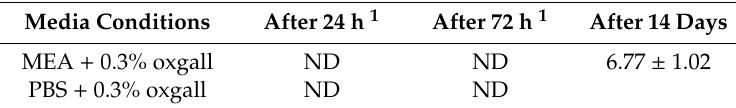
e ff ectiveness, a set of M. purpureus cultures grown in MEA + 0.3% oxgall at 24 h and 72 h were spiked with citrinin at 10 µ g / mL and extracted. Recovery of citrinin was 72.9% ± 3.8. Table 6. Citrinin production under experimental conditions. Citrinin concentration ( µ g / mL) of M. purpureus CBS 109.07 under experimental conditions of growing and resting phases was measured at 24 and 72 h via HPLC-UV. Two independent trials were conducted for each time point. Standard deviation in cholesterol content is absolute